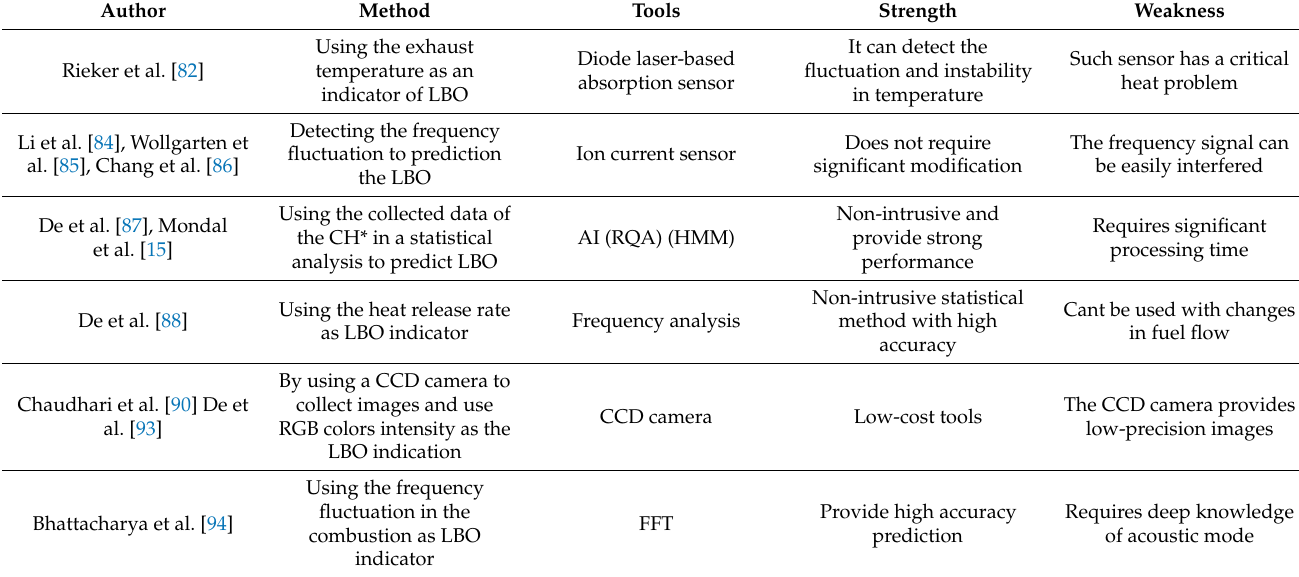
Table 4. The top experimental techniques